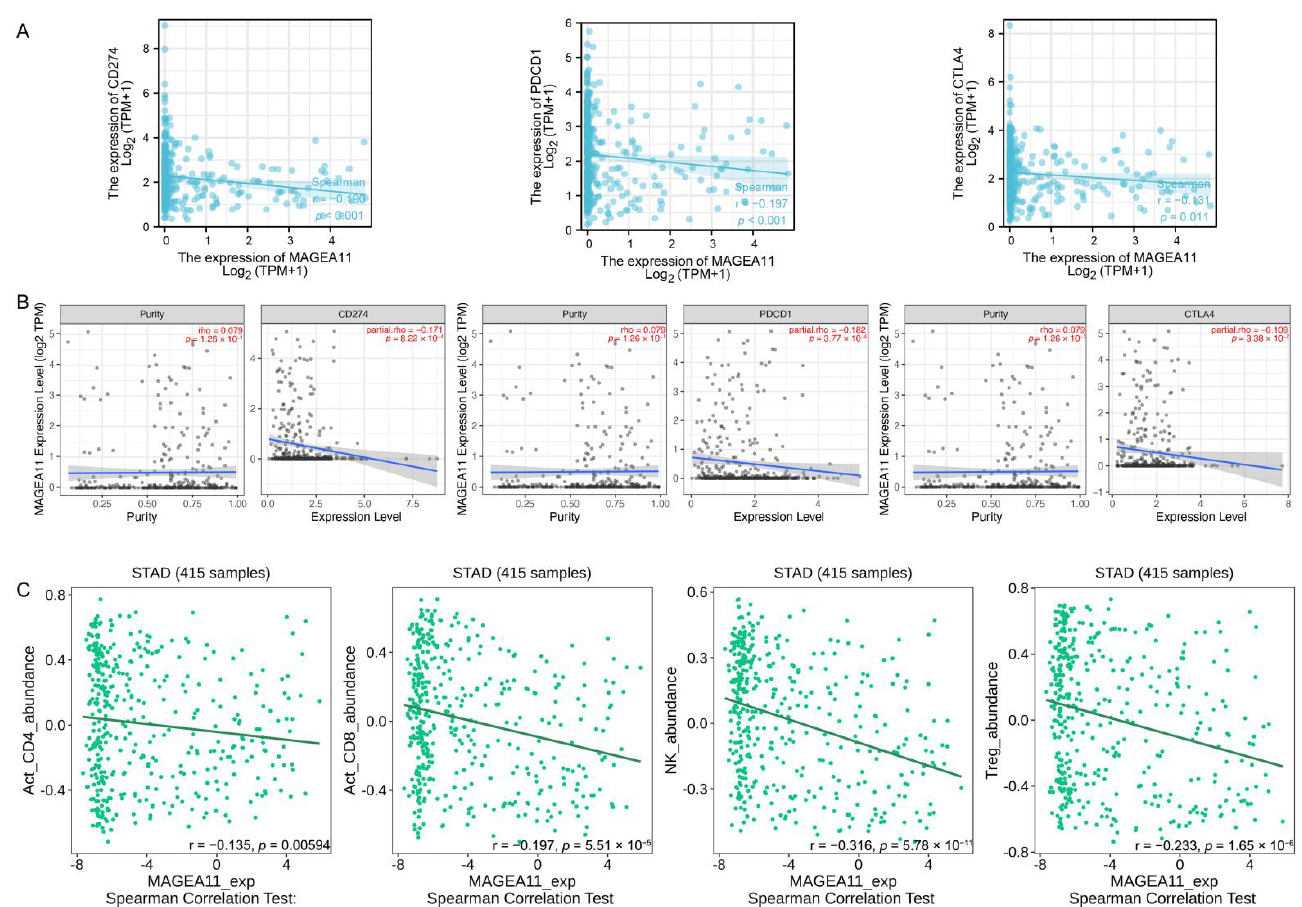
Figure 6. Correlation of MAGEA11 with immune checkpoints and immune cell infiltration. Correlation between MAGEA11 and PD-L1 (CD247), PD-1(PDCD-1), CTLA-4 expression in ( A ) the TCGA-STAD database and ( B ) TIMER database, respectively. ( C ) MAGEA11 and Act_CD4 + T cells, Act_CD8 + T cells, NK cells, and Treg cells’ correlation abundance.